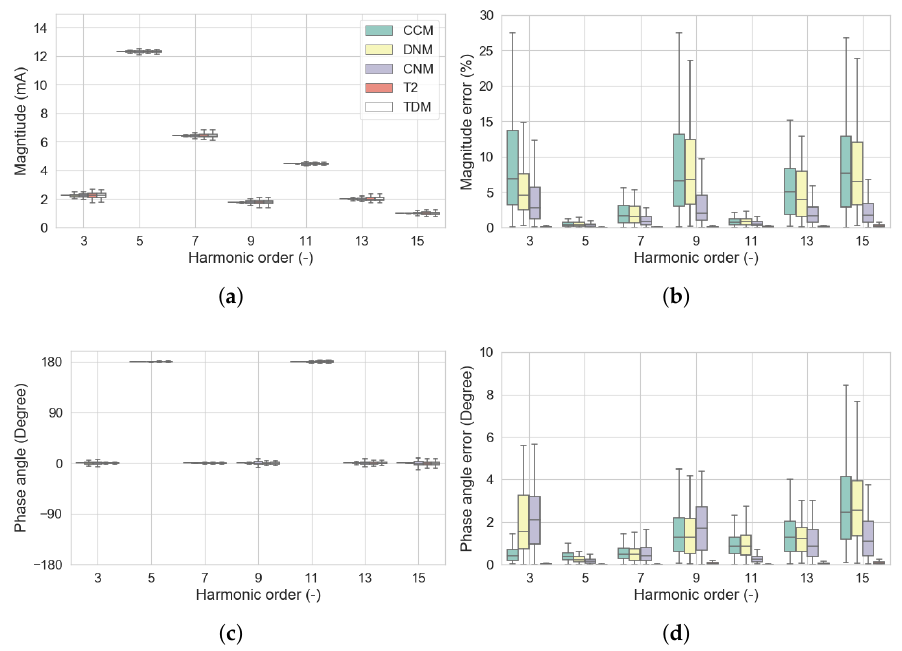
Figure 16. Comparison of the Type C LED lamp frequency domain models for peak-top voltage supply: ( a ) Magnitude; ( b ) Magnitude error; ( c ) Phase angle; and ( d ) Phase angle error. Figures 15–17 are equivalent to those for Type A and B LED